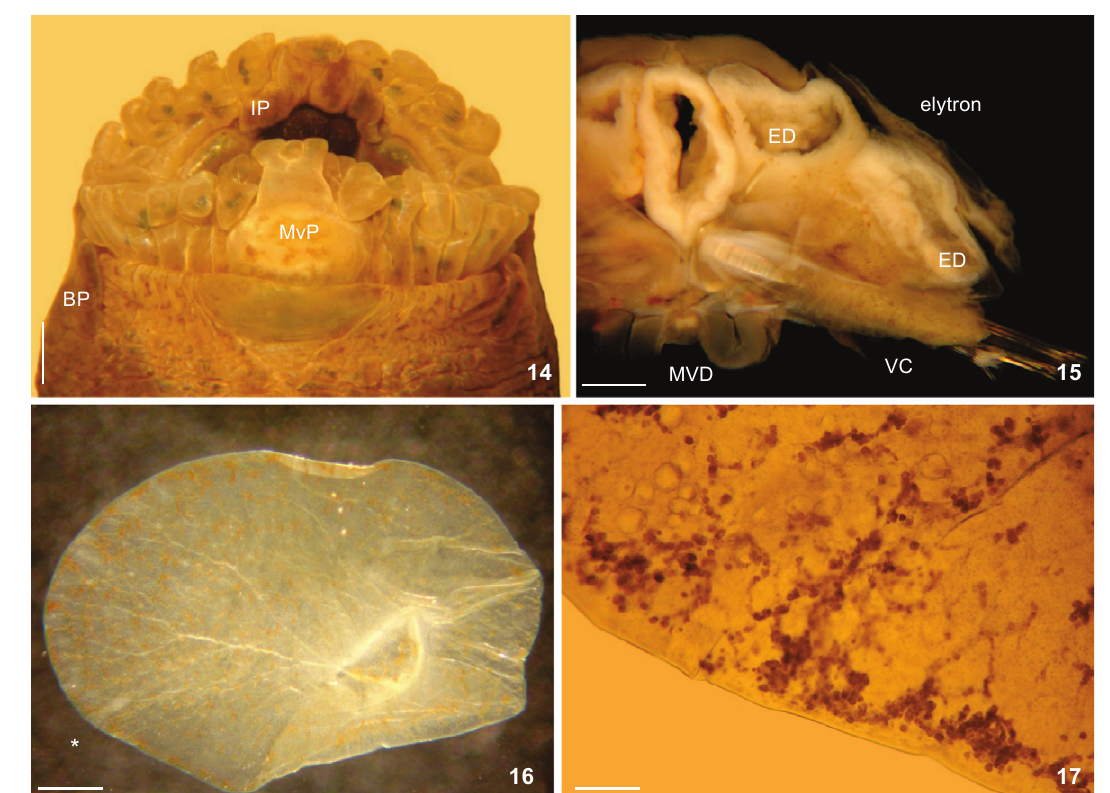
Figures 14-17. Euarche rudipalpa , (UERJ 4024): (14) pharynx, oblique ventral view; (15) chaetiger 60, posterior view, transverse cut; (16) right elytron from chaetiger 8, frontal view (*enlarged area in Fig. 17); (17) same, close-up of dorsal, posterior, marginal area showing brownish spots and microtubercles. (BP) basal papilla, (ED) enteric diverticulum, (IP) internal papilla, (MVD) mid-ventral depression, (MvP) mid-ventral papilla, (VC) ventral cirrus. Scale bars: 14 = 1.7 mm, 15 = 1 mm, 16 = 0.5 mm, 17 = 65